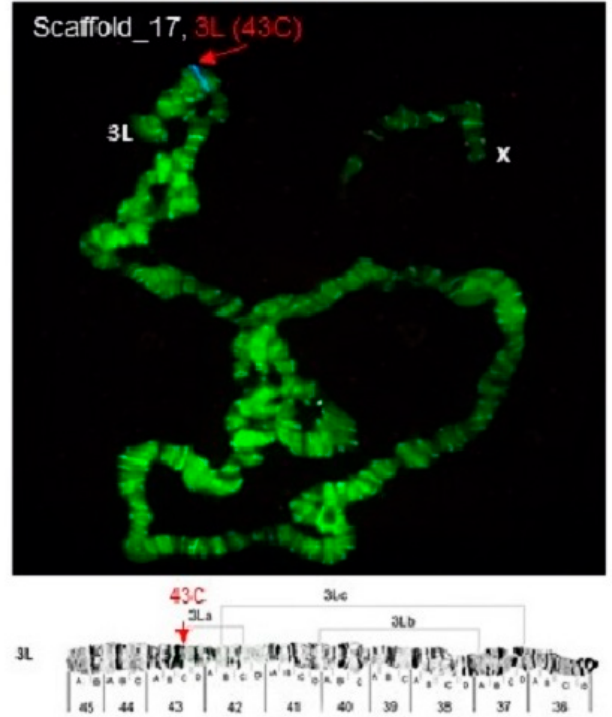
Figure 6. Pb22b-Cy 5 probe, mapped in 3L (43C), a region involving the chromosomal inversion 3La in An. darlingi, as shown by arrows [19]. Chromosomal bands with positive hybridization are identified with text in red, and the corresponding scaffolds in An. darlingi genome assembly AdarC3 are indicated in white text.